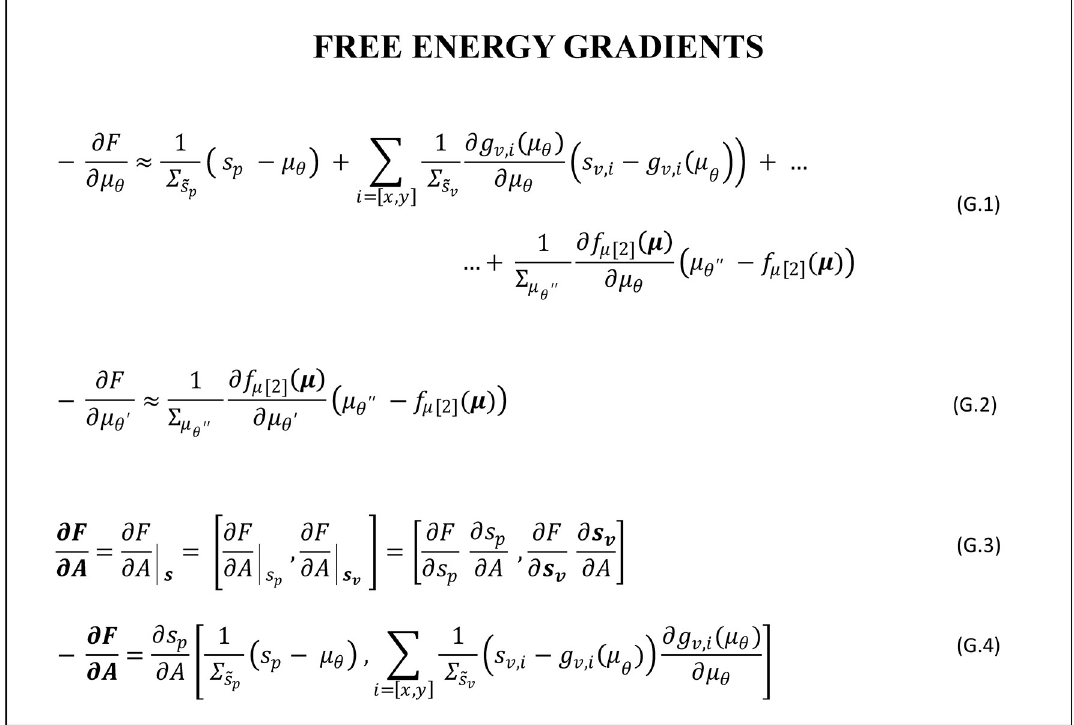
Fig 6. Derivation of the free energy gradients for the active inference agent. Please see the main text for a detailed explanation.